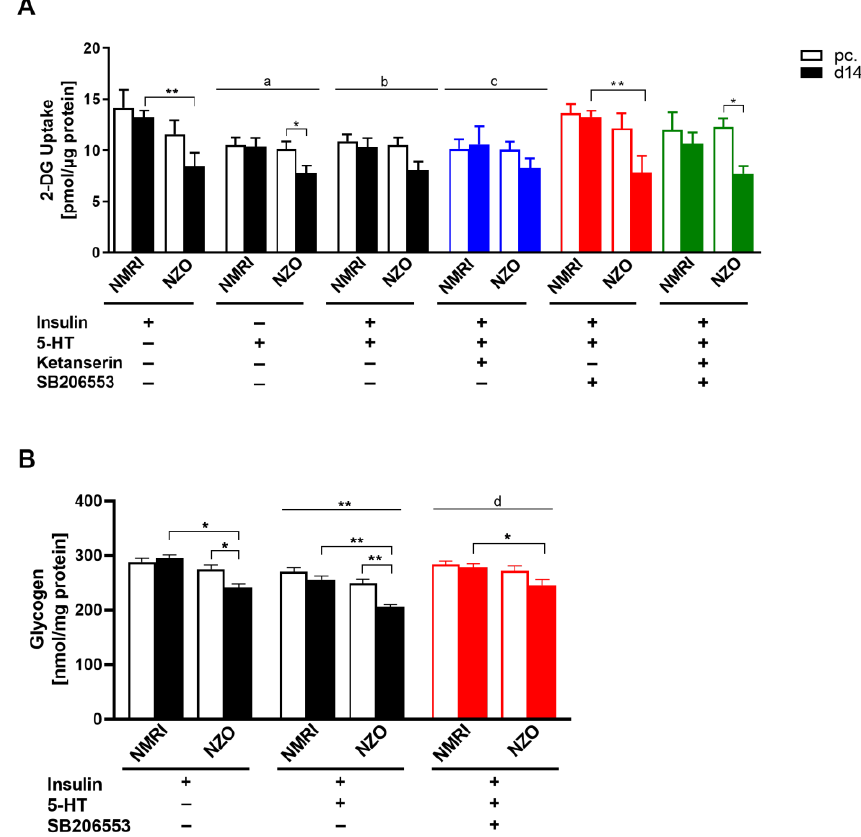
Figure 7. Impact of 5-HT on hepatic glucose metabolism in primary hepatocytes. ( A ) 2-DG uptake with insulin and 5-HT stimulation or co-incubation with 5-HTR antagonists. Co-incubation with Ketanserin (HTR2A antagonist) and SB206553 (HTR2B/C antagonist). ( B ) Glycogen content with insulin preincubation and 5-HT or SB206553 stimulation in cultured primary hepatocytes of NMRI and NZO mice at time points preconceptional (open bars) and d14.5 of gestation (filled bars). Data are presented as means ± SEM ( A n = 4–6, B n = 5 animals per group). * p < 0.05, ** p < 0.01, multiple comparison tests results between groups: A +I vs. +5-HT: a p < 0.05, +I vs. +5-HT+I: b p = 0.063, +I vs. +5-HT+I+K: c p < 0.05, +I vs. +5-HT+I: ** p < 0.01; B +5-HT+I vs. +5-HT+I+SB206553: d p < 0.01.